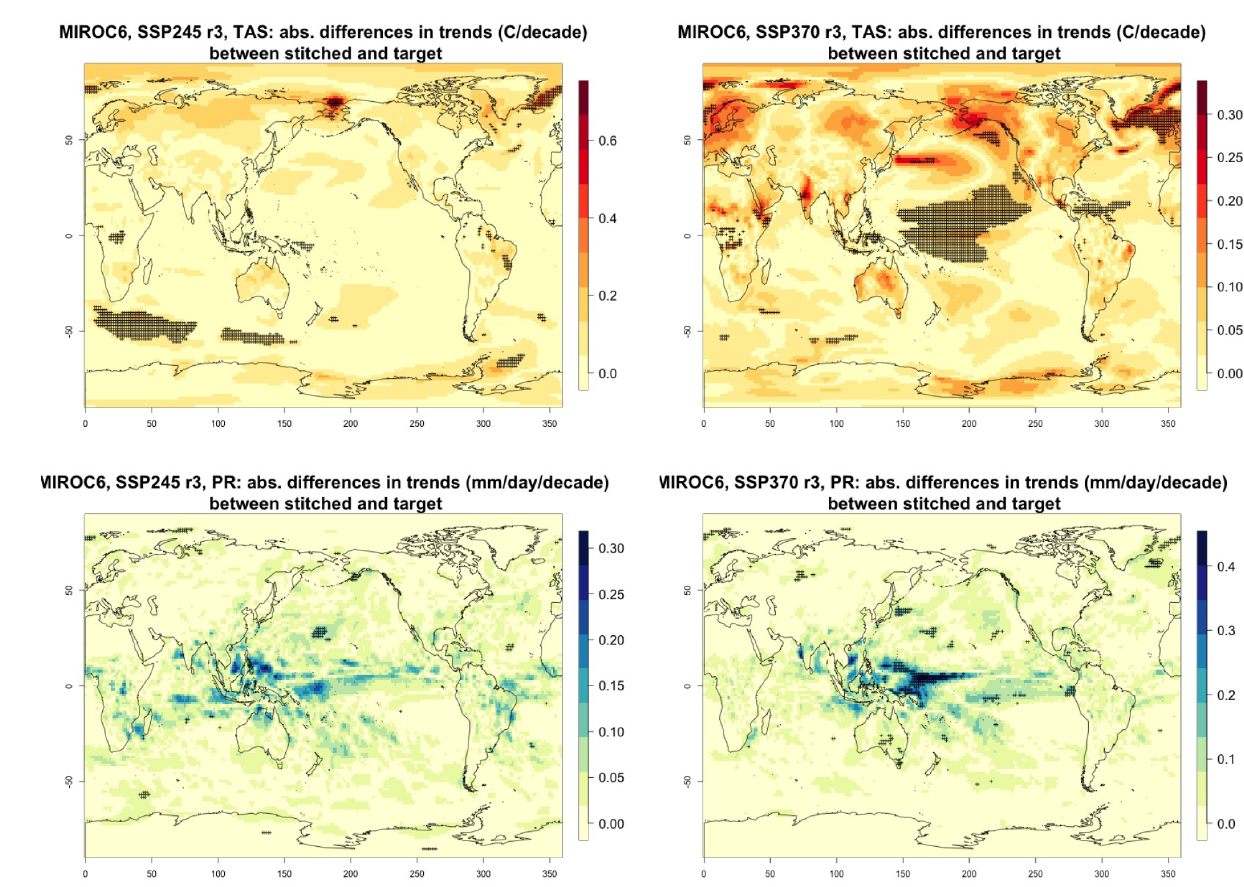
Figure C3. Absolute difference in decadal trends of temperature (TAS) and precipitation (PR) between stitched and target realizations. The value of the difference is expressed by the color scale, and we marked as significant with black crosses those locations where the 95% confidence intervals of the trends computed from target and stitched time series do not overlap, indicating statistically significant differences. Emulation of MIROC6, monthly time series over 2015–2100, for SSP2-4.5 and SSP3-7.0. Third realization.